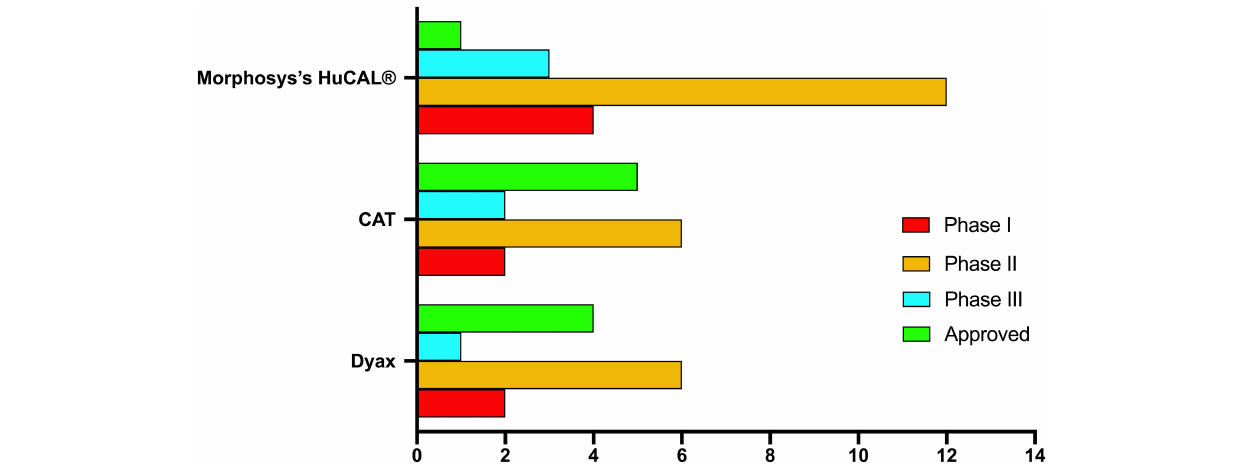
selection of phage display-derived therapeutics was described in great detail previously (171, 172), yet we here present an updated and comprehensive review of phage display-derived